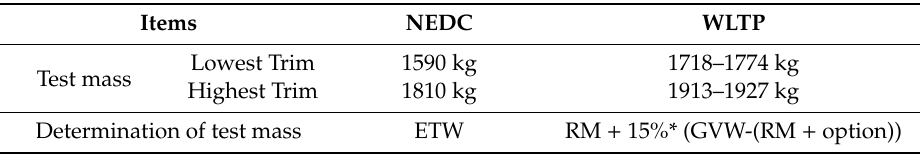
Figure 14. Operation time and fuel amount according to coolant and engine oil temperature (Diesel 1.6 VGT engine) .